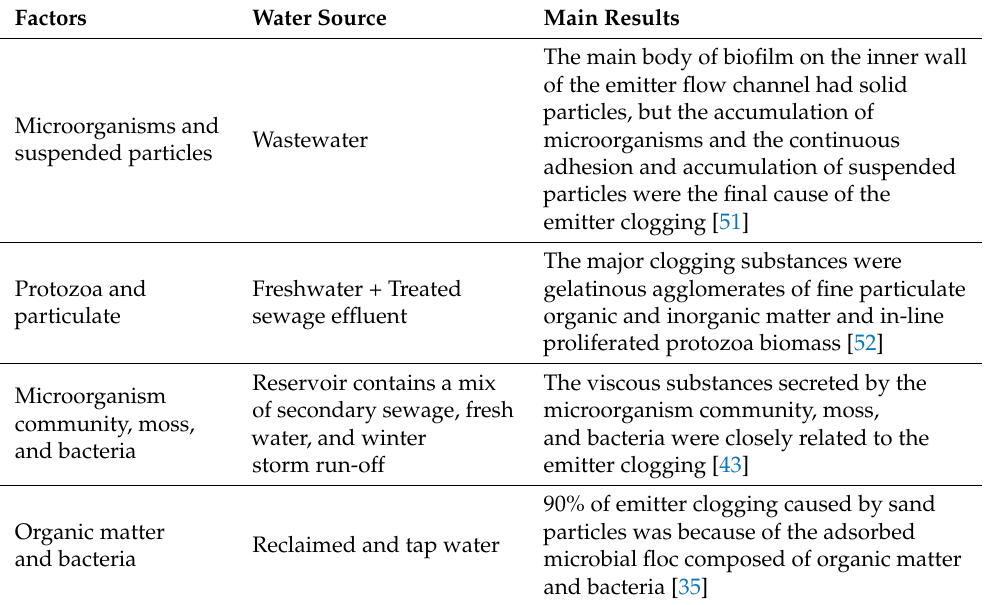
Table 2. The main factors causing emitter biological